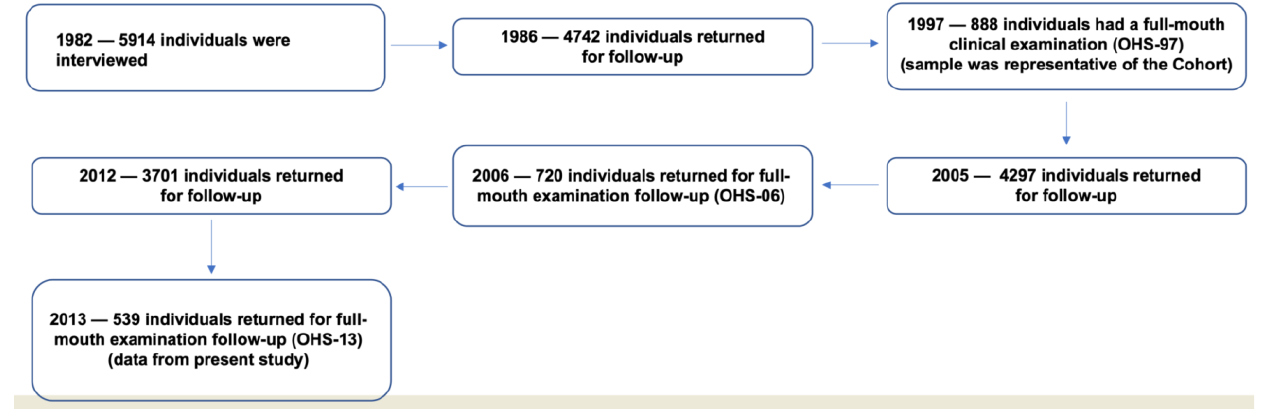
Figure 1. The flowchart of the 1982 Pelotas Birth Cohort Study.